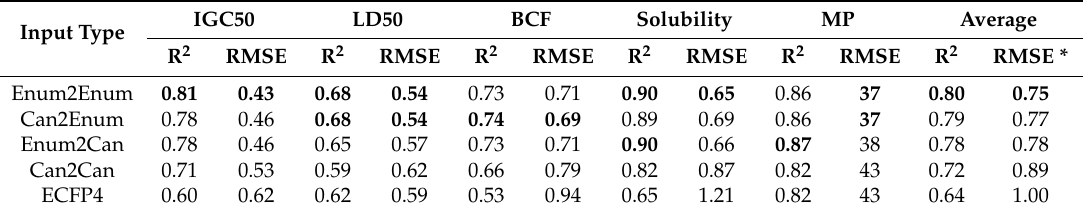
Table 4. Performance of the QSAR models on the held out test-set for different input data. The best performance for each metric and dataset is highlighted in bold. R 2 is the squared correlation coefficient (closer to one is better), RMSE is the root mean square error of prediction on the test set (lower is better). Input